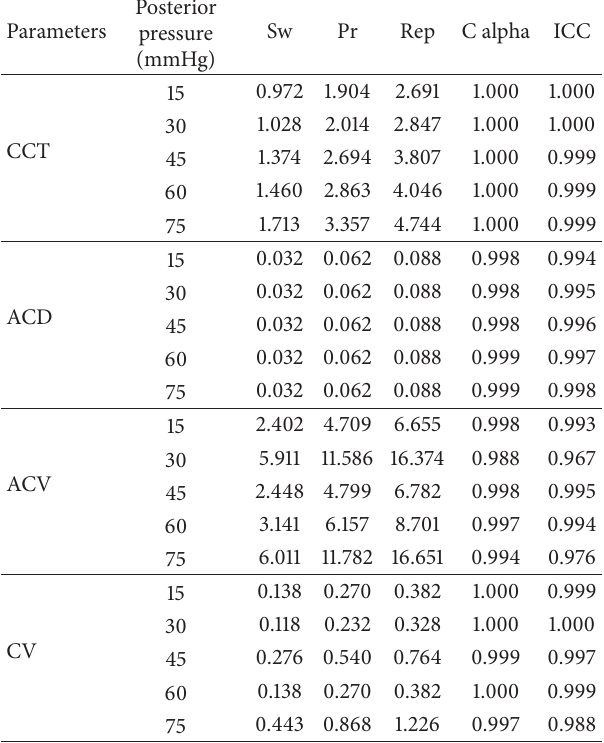
Table 1: Summary of intraobserver repeatability and reliability for the parameters.